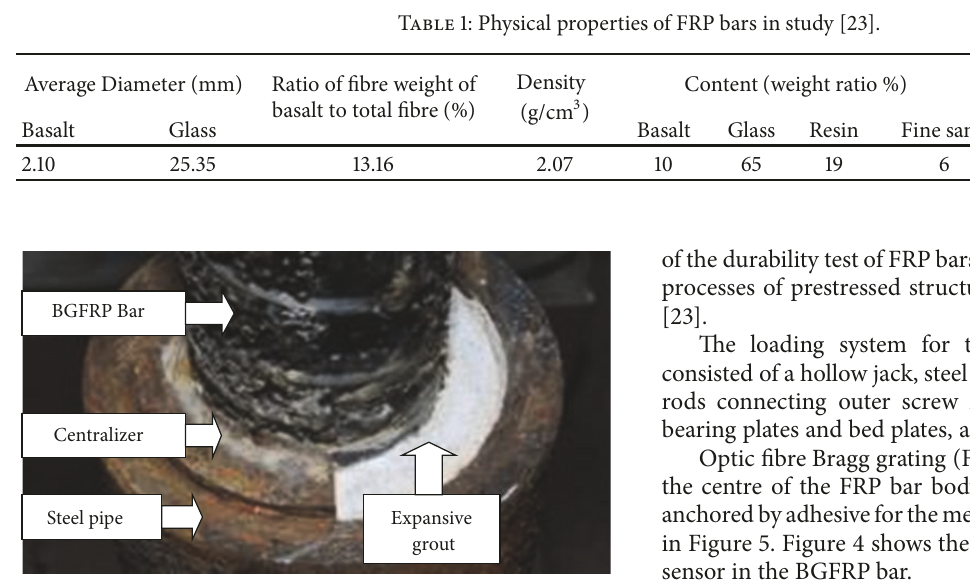
Figure 2: Diagram of centralizer keeping FRP bar central.